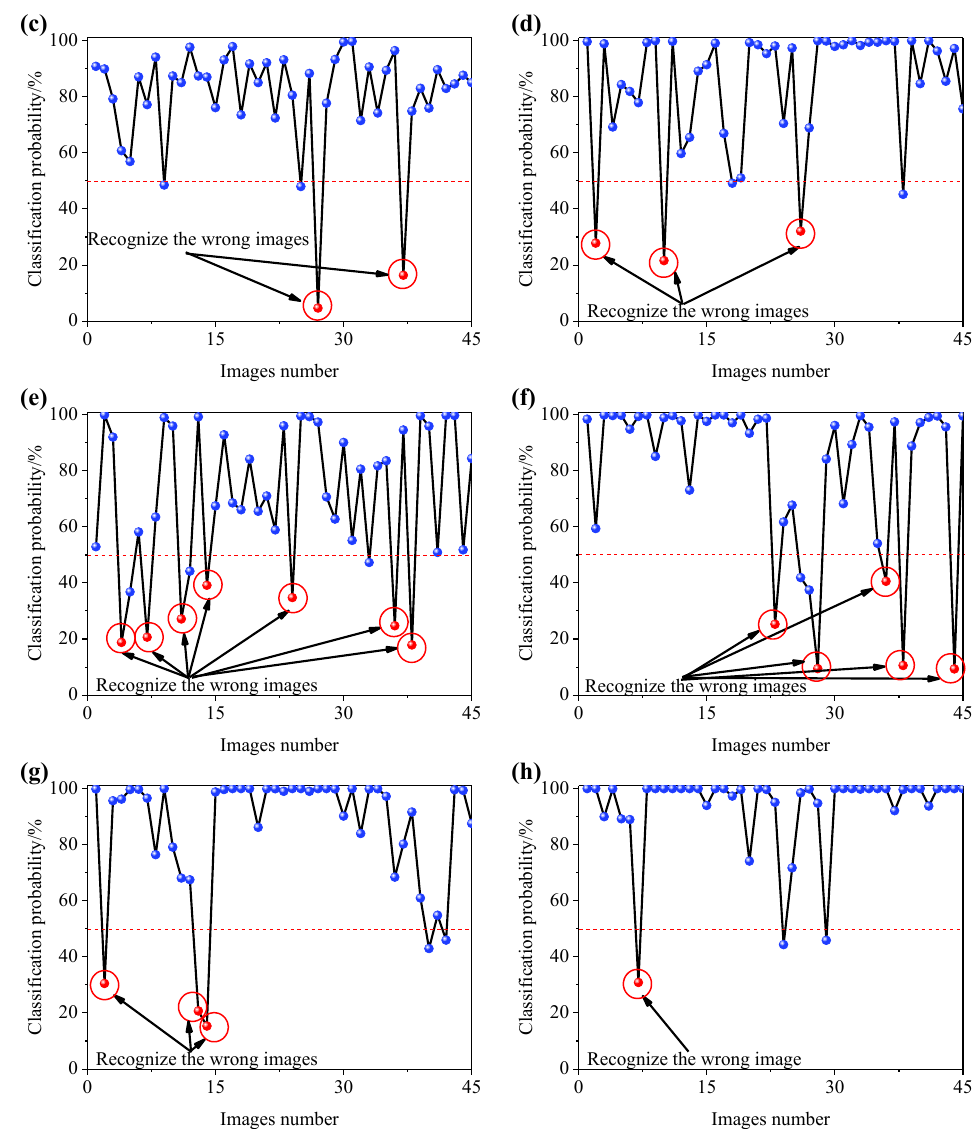
Figure 11. Proposed model recognition result probability of each defect image on the testing set: ( a ) LM, ( b ) BS, ( c ) CP, ( d ) EC, ( e ) Ho, ( f ) IS, ( g ) Pe, and ( h ) Sm.